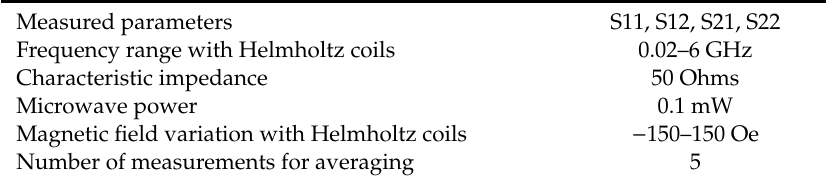
Table 1. Microwave measuring system characteristic parameters.